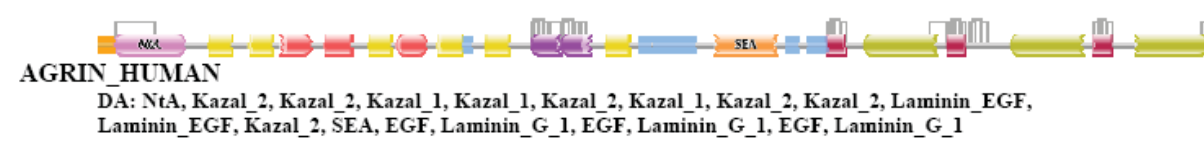
Figure S9. Comparison of the domain architecture of AGRIN_HUMAN with those of some of its